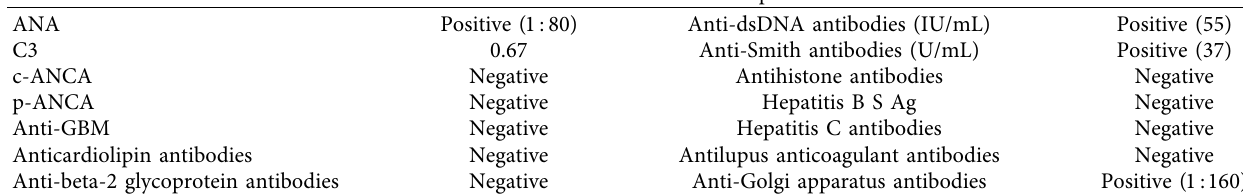
Table 2: Autoimmune workup.